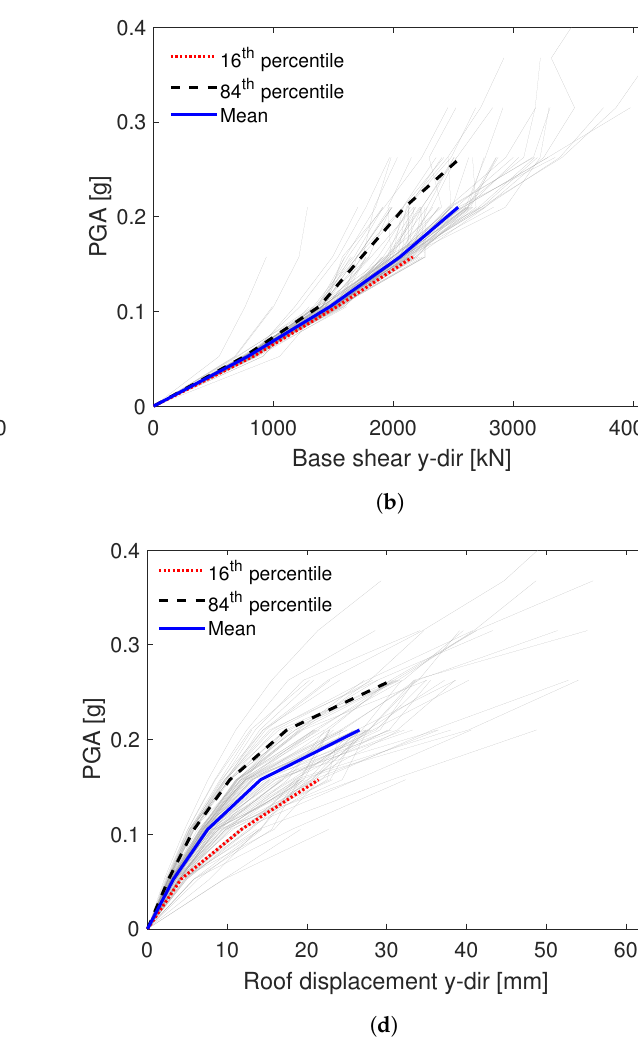
Figure 20. Lausanne Malley model (with out-of-plane disabled and rigid connections) IDA curves displaying the maximum values of seismic demand parameters: ( a ) Total base shear in x-direction. ( b ) Total base shear in y-direction. ( c ) Average roof displacement in x-direction. ( d ) Average roof displacement in